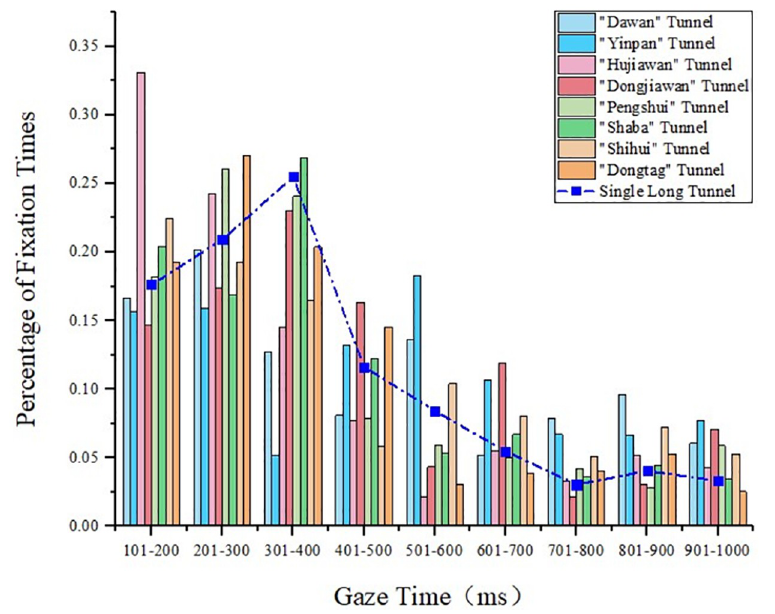
Fig 5. Statistical diagram of the gaze time of the long tunnels in the tunnel